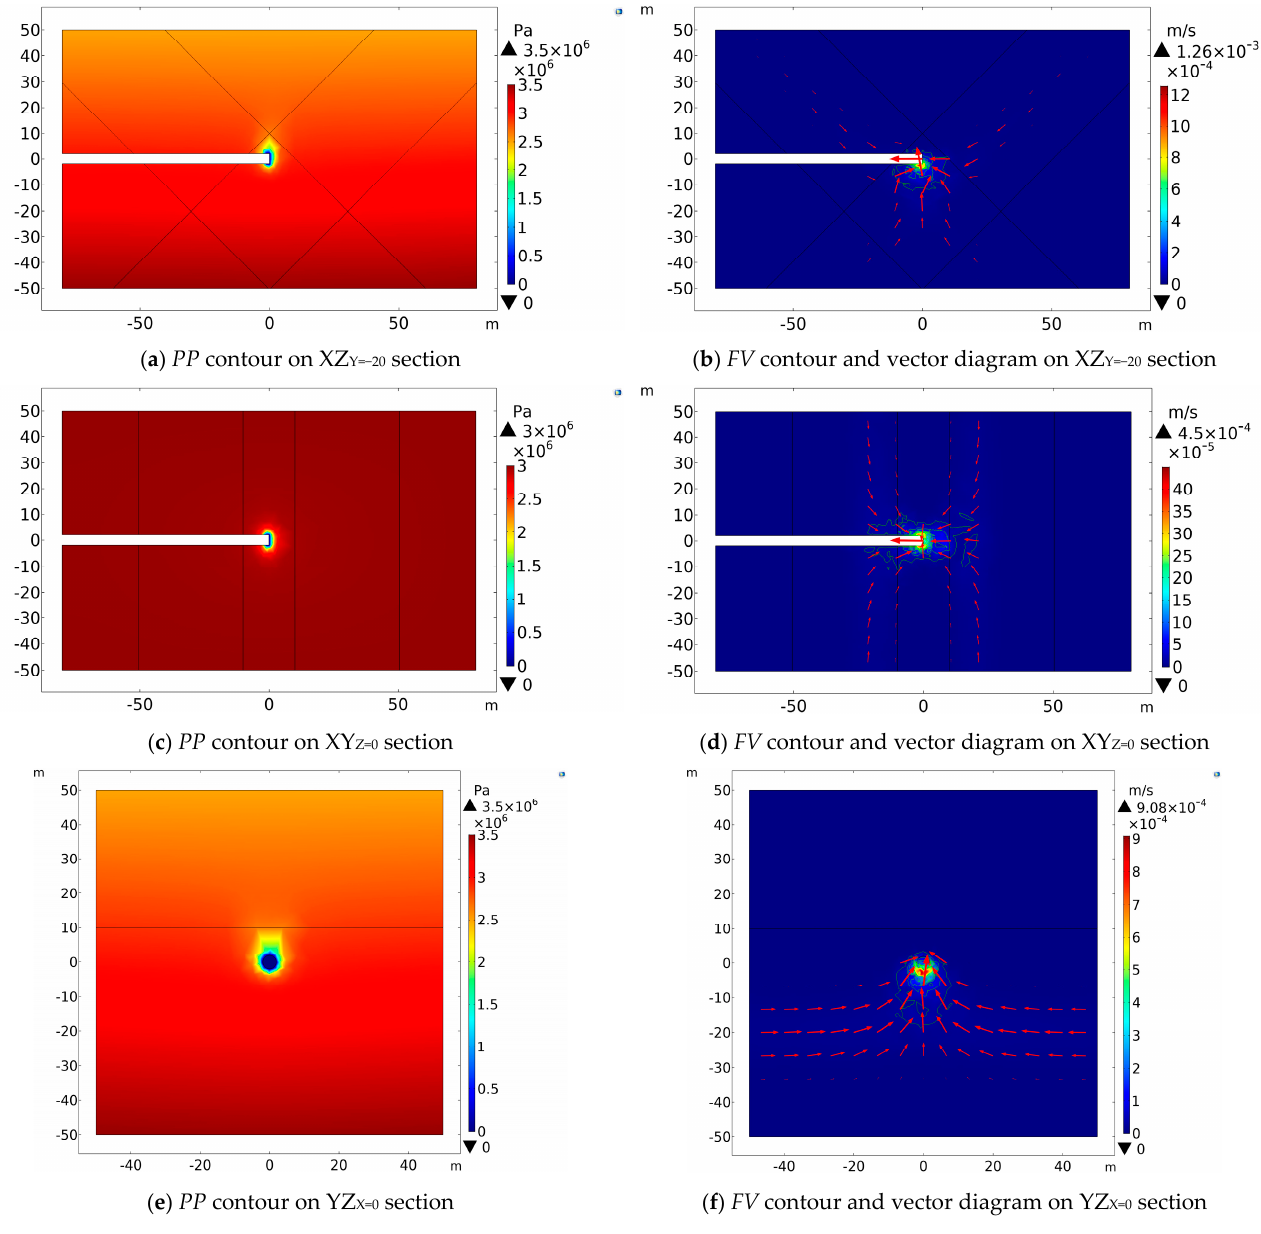
Figure 8. Simulation results for the case Y = − 20 m.